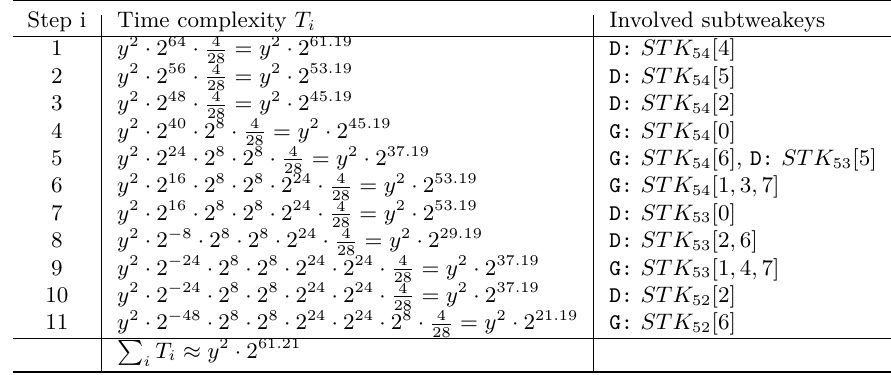
Table 14: Time complexity, guessed and deduced subtweakeys of each step in the tweakey recovery process for 28-round ForkSkinny-128-256 (256-bit